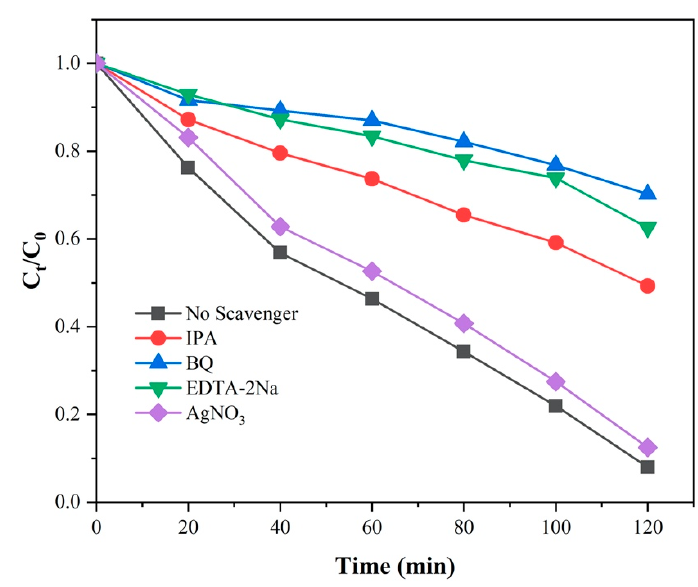
Figure 11. Radical quenching experiments over 3-ALG.